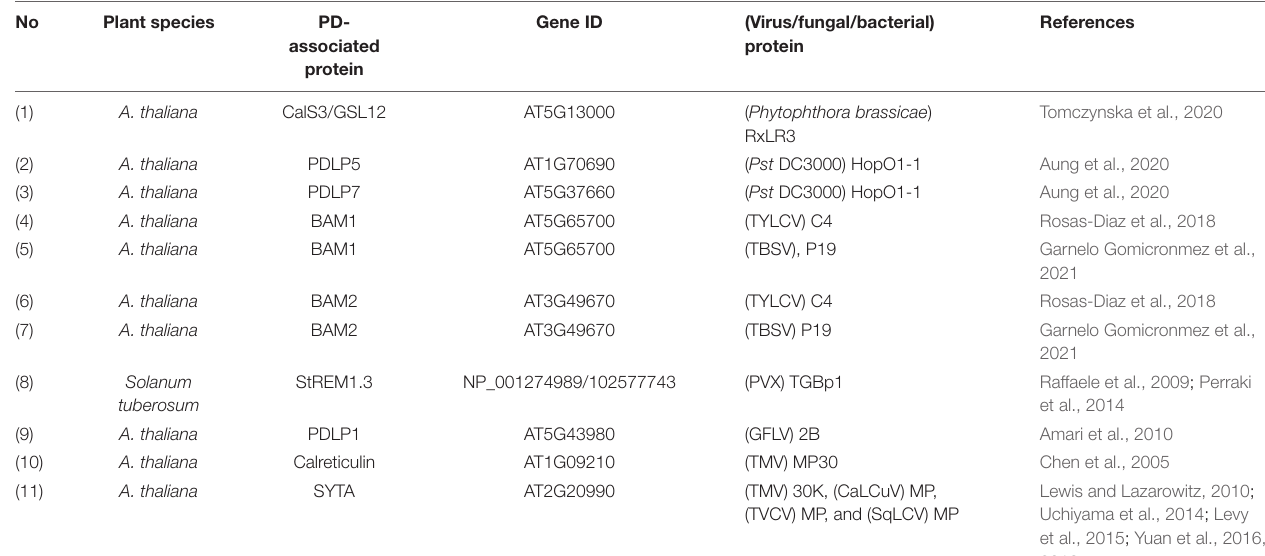
TABLE 3 | PD-associated proteins and their interactions with virus/fungal/bacterial proteins. No Plant